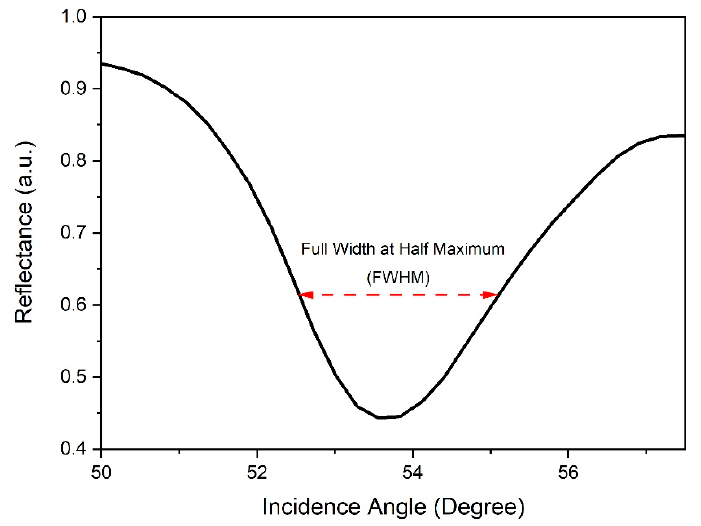
Figure 15. Illustration of FWHM, which represents half of the maximum value on the reflectance curve (for deionized water).